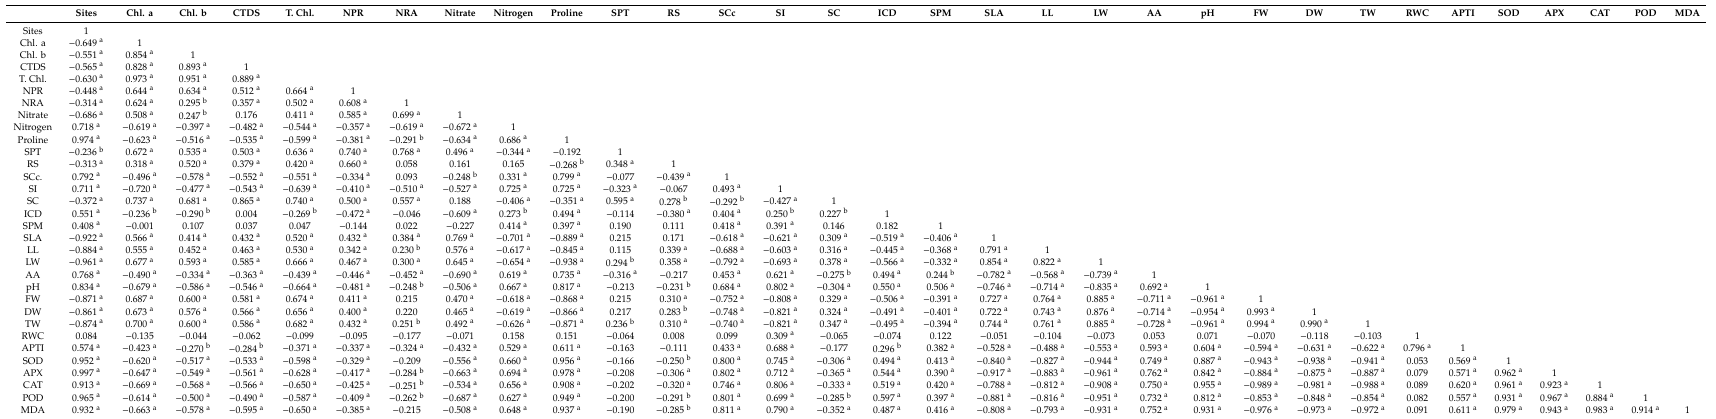
Table 3. Correlation coe ffi cients for linear regression between biochemical parameters, leaf attributes of P. dulce at three di ff erent